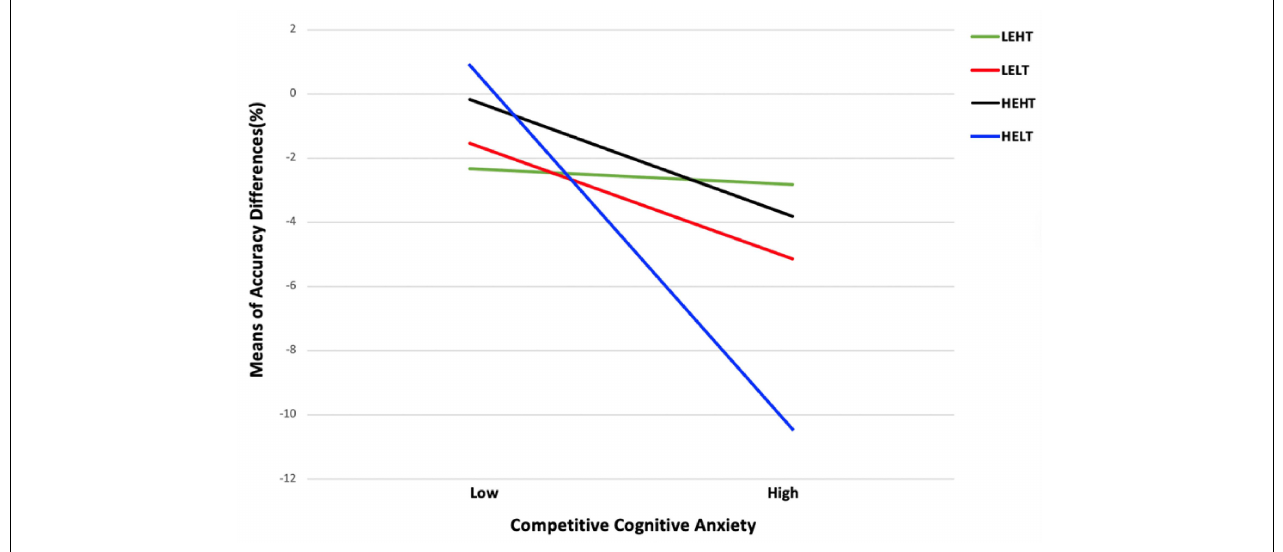
FIGURE 3 | The association of competitive cognitive anxiety with accuracy differences between two sessions (S2–S1) among athletes with four goal profiles. Note. LEHT, Low-ego/high-task; LELT, low-ego/low-task; HEHT, high-ego/high-task; and HELT, high-ego/low-task.